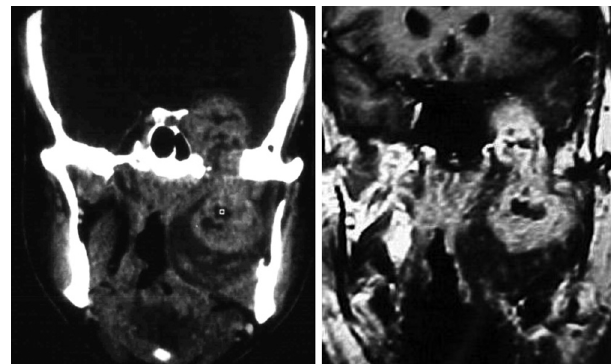
Figure 2 Mandibular nerve schwannoma: coronal computed tomography and magnetic resonance imaging show a hourglass- like mass with a localized shaft and widening of the oval foramen, with intracranial components and in the masticator space.